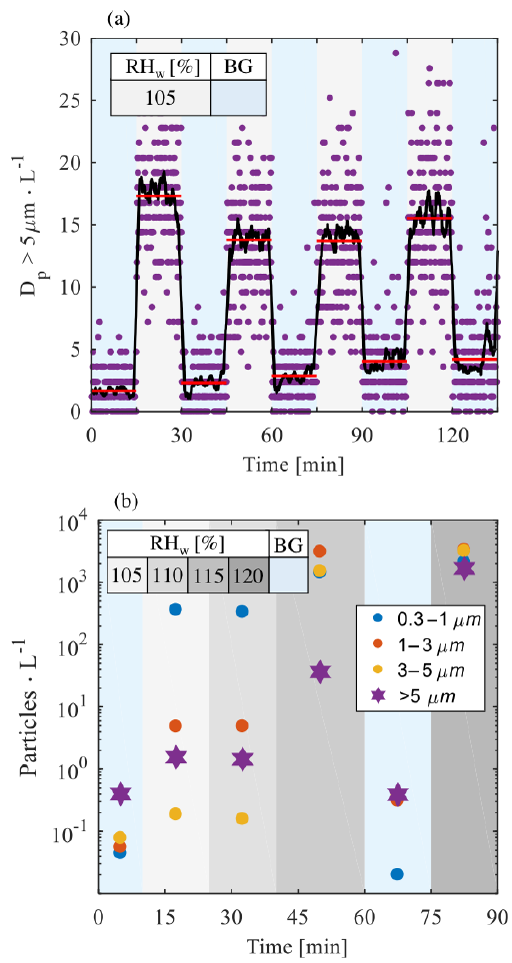
Figure 7. Initial data collected using the PINCii chamber. A four- channel optical particle counter (OPC) placed at the exit of the ice growth chamber is used to count particles exposed to various ther- modynamic forcing illustrated using the chamber relative humid- ity with respect to water RH w ; in all cases presented here the ex- perimental temperature was − 32 ◦ C. The sample flow is initially directed through a 2.5 µm impactor to eliminate large particles, and after the ice growth chamber the flow is exposed to an evap- oration section where ice particles continue to grow while liquid droplets shrink. (a) An example of 15min incremented measure- ments of clean, background (BG) air and ambient air containing counted INPs ( D p > 5µm) at RH w = 105%. The data points show the raw OPC data acquired as 5s time averages of 1s data; the black line depicts a 2min centred moving average, and the red lines are the 15min increment averages. The data are also illustrative of the slow increase in the chamber’s background contribution over 2 to 3h, in line with existing CFDC systems. (b) Increment averages il- lustrative of the chamber’s so-called “droplet breakthrough” when at the highest RH w (cid:38) 115% particle numbers in all size bins are am- plified because liquid droplets no longer fully disappear within the evaporation